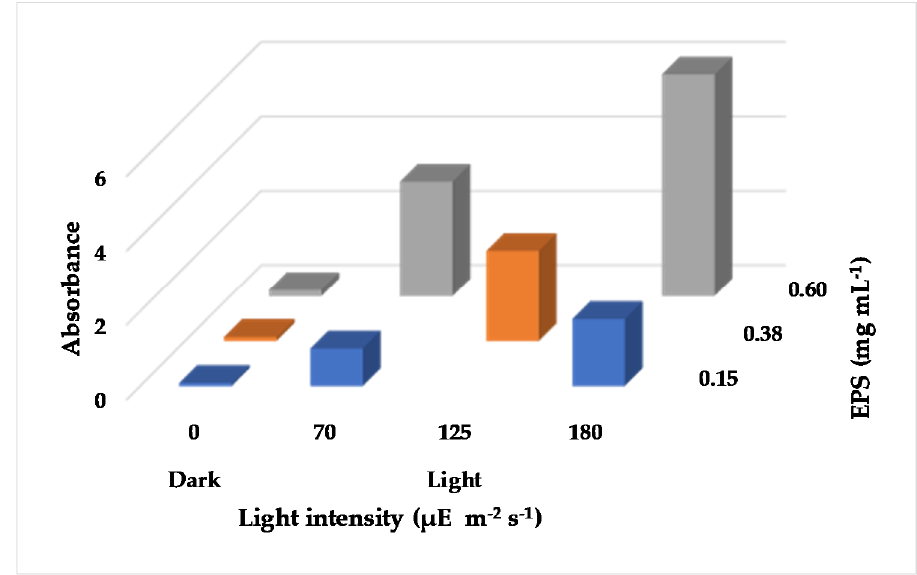
Figure 6. 3D bar graph showing the maximum SPR absorbance at various light intensities and EPS concentrations.